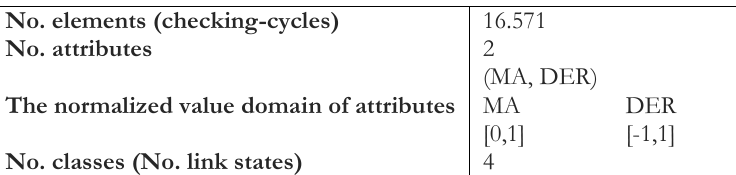
Table 1. The descriptions of the experimental dataset.